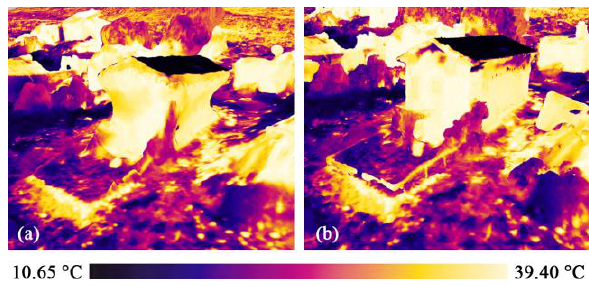
Figure 13. (a) Texturized thermal mesh (the thermal dataset has been used for both mesh generation and texturization). (b) Texturized thermal mesh resulting from data fusion between optical dataset and thermal dataset.